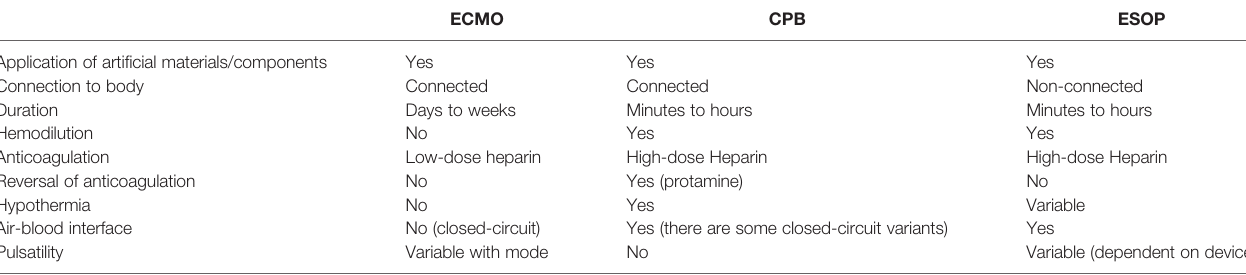
TABLE 1 | Differences between extracorporeal life support techniques and ex-situ thoracic organ perfusion.